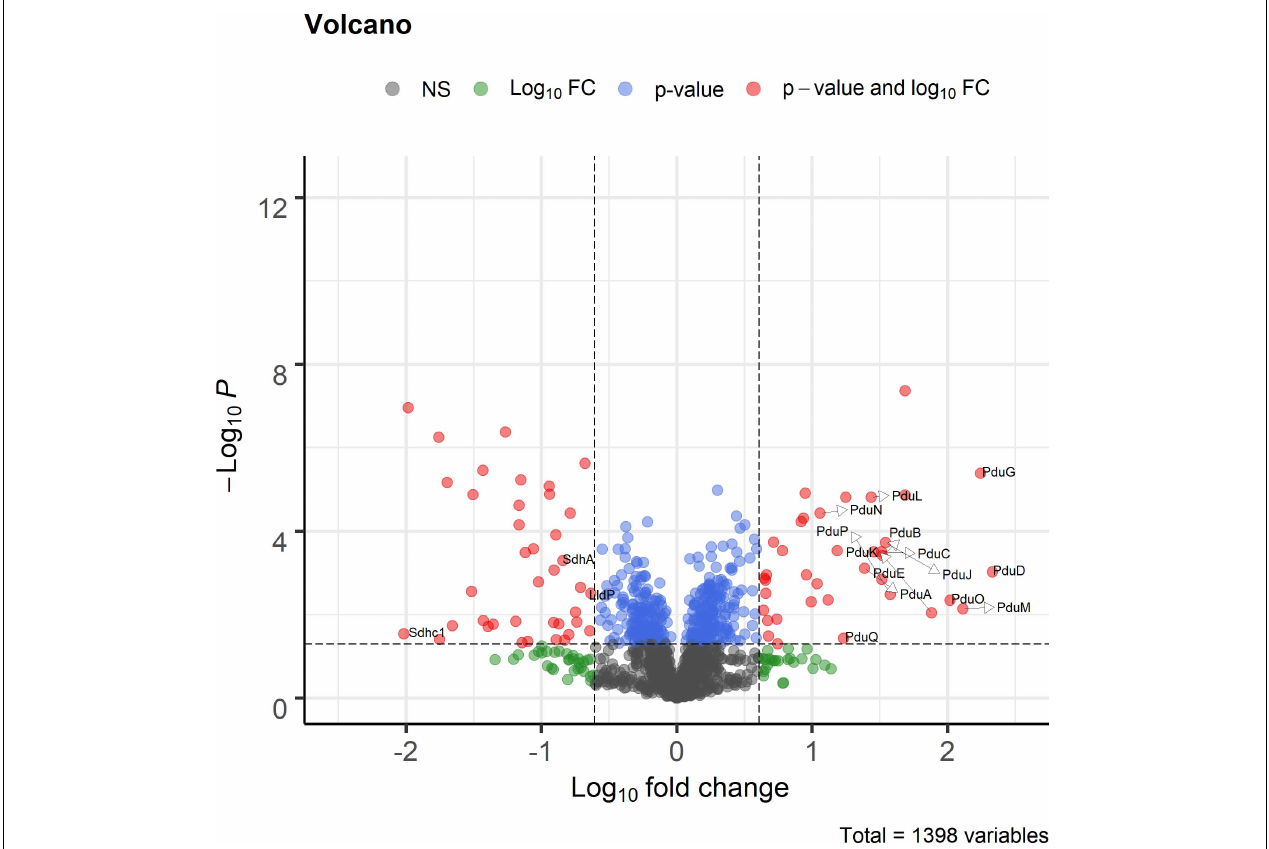
FIGURE 4 | Volcano plot of proteomic analysis of cells grown in 1,2-propanediol media and L -lactate media. Positive log 10 fold change indicate upregulation in 1,2-propanediol-grown cells, negative log 10 fold change indicate down regulation in 1,2-propanediol-grown cells compared to lactate-grown cells. Red dots indicate proteins with p < 0.05 and 4-fold difference expression. Blue dots indicate only p < 0.05, green dots only 4-fold difference. Black dots indicate non-significant, non-differentially expressed proteins ( n = 3 biological replicates).